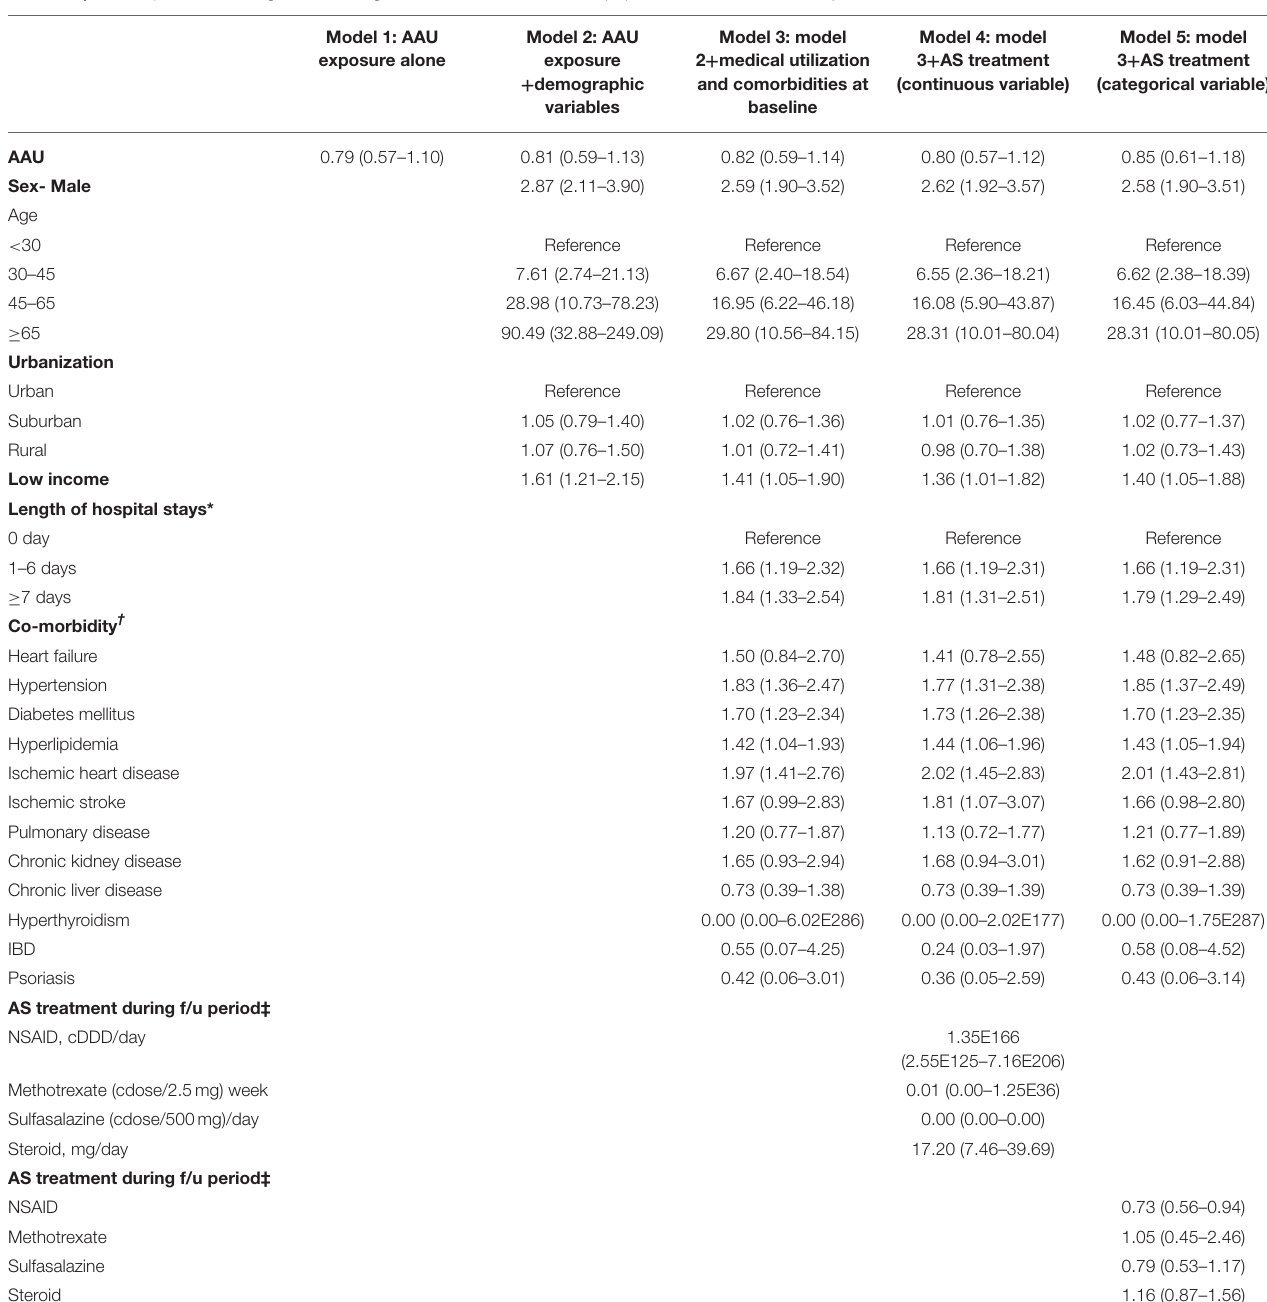
TABLE 4 | Time dependent cox regression 1:4 age-matched and sex-matched population for estimation of adjusted HRs on